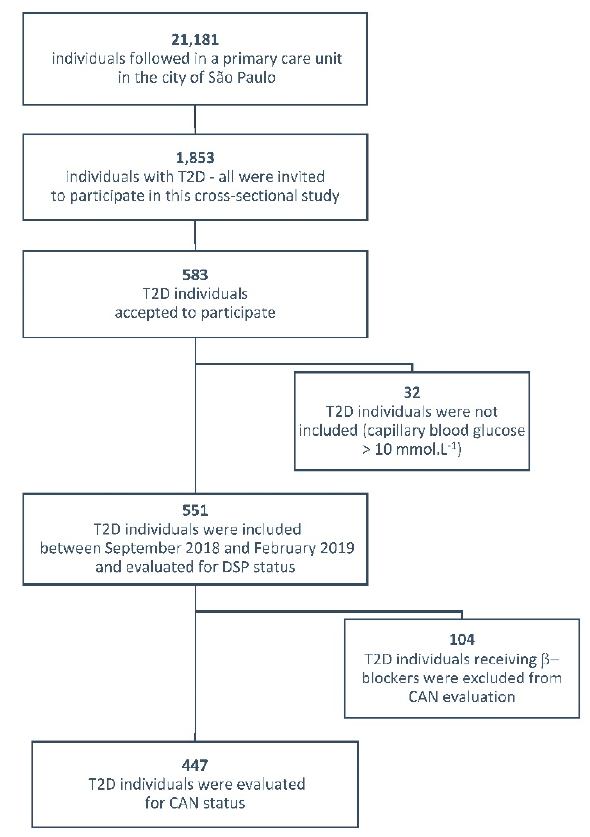
Figure 1. Flow diagram showing the recruitment of type 2 diabetes (T2D) individuals in the study. DSP: Distal symmetric polyneuropathy; CAN: Cardiovascular autonomic neuropathy.